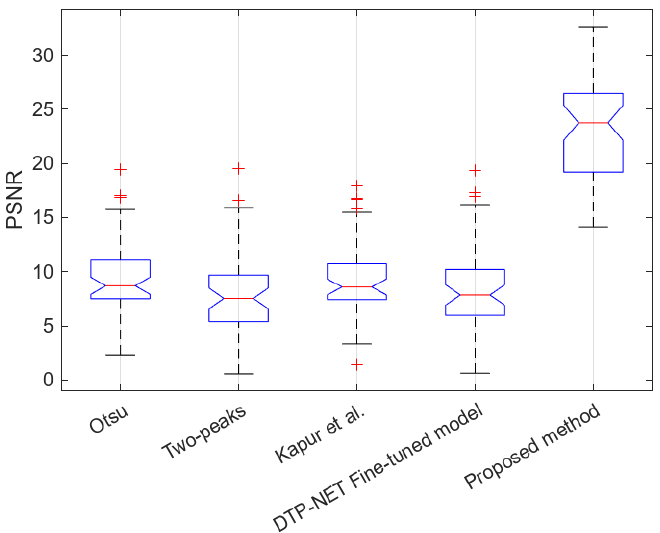
Figure A1. Multiple comparisons test: pair-wise comparison of different methods based on the PSNR scores. The central red line indicates the median PSNR value of each method, and the blue box is the interquartile range (IQR), indicating the 25th and 75th percentiles of the PSNR dataset. The dashed black line represents the whiskers, extending to the minimum and maximum data points. Statistical outliers are marked using the red ’+’